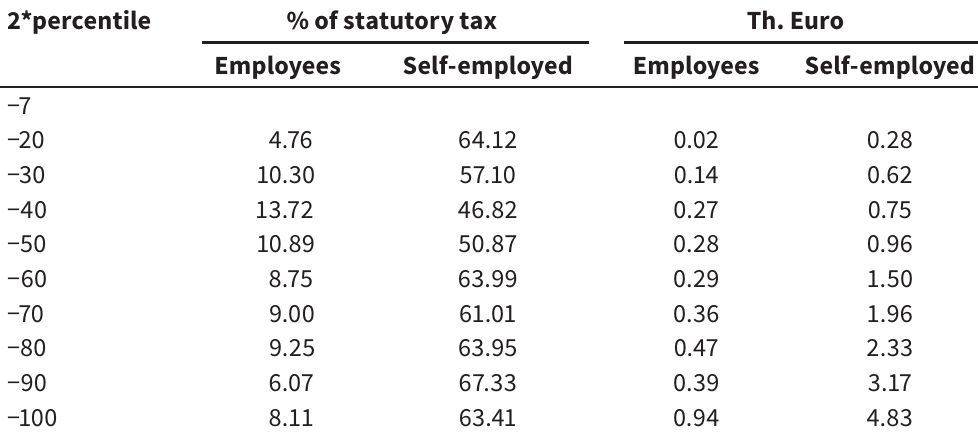
Estimated difference between statutory and effective tax schedules per